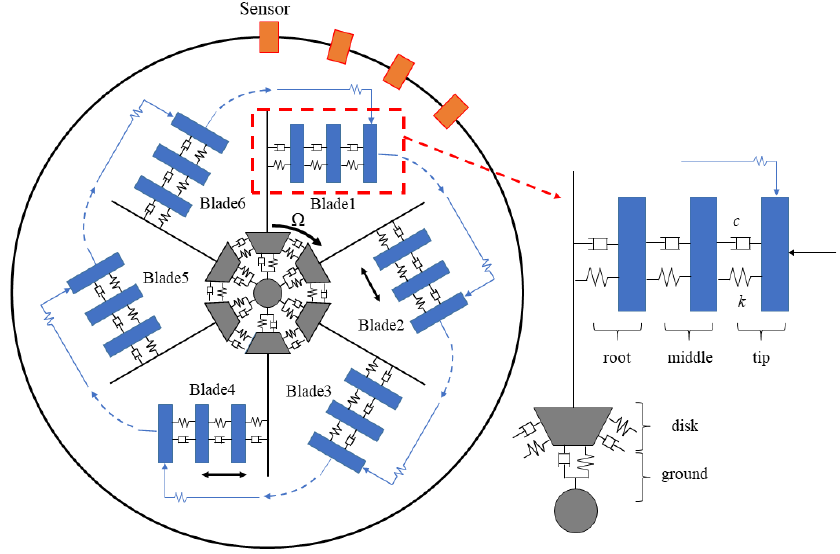
Figure 2. The lumped parameter